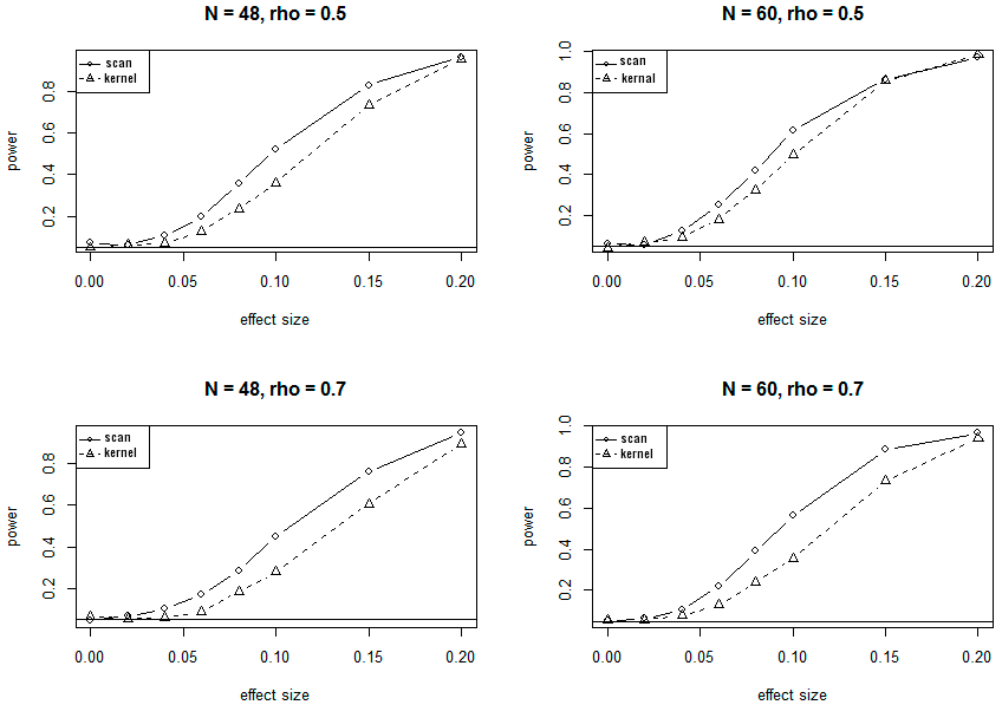
Figure 3. Power curves for SSM and KDM with 30 CpG sites at α = 0.05. rho ( ρ ) is the correlation of methylation rates between adjacent CpG sites.